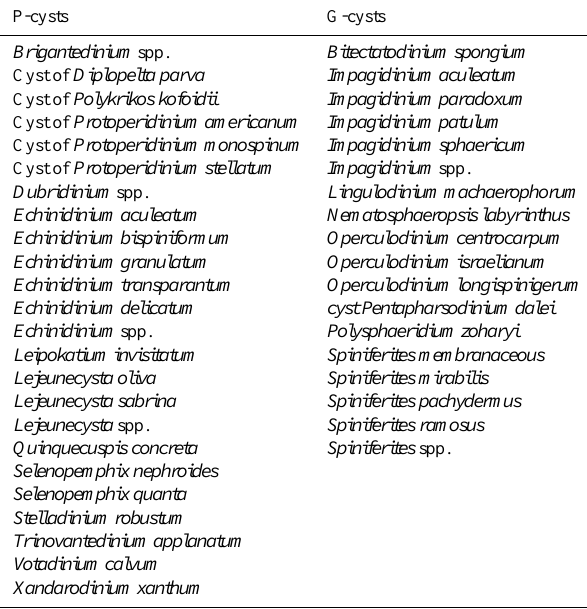
Table 2. Gonyaulacoid (G) along with peridinioid and cysts of Polykrikos (P) dinoflagellate cyst species identified in this study. These species correspond generally to those that are more resistant to oxidation (G-cysts) and those that are more sensitive (P-cysts), based on Zonneveld et al.